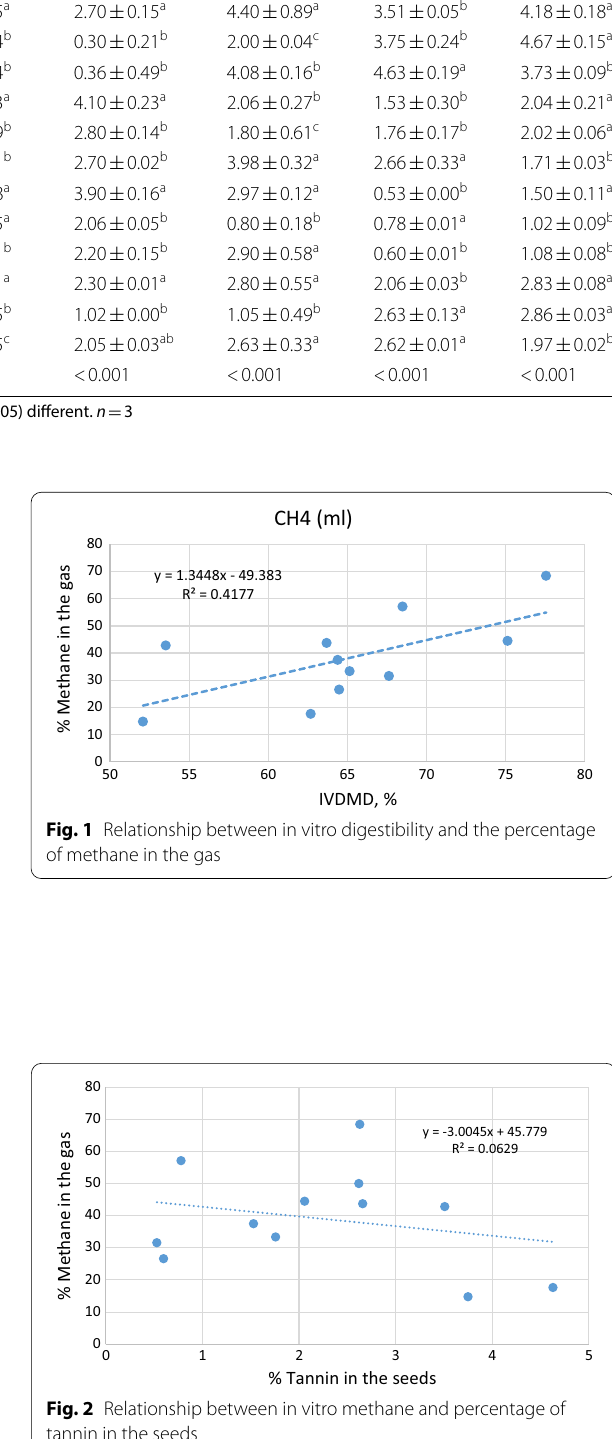
Table 2 Mineral and anti-nutrient compositions (g/100g DM) of raw and differently processed Tomentosa nilotica, Dioclea reflexa and Monodora myristica seed meals Seeds